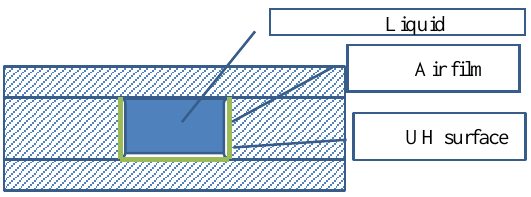
Fig 3. The geometry of the air film formation in the mini- channel. [3]